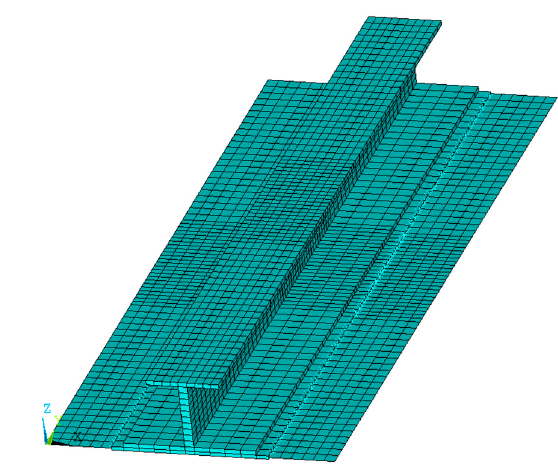
Figure 4. Geometrical model.